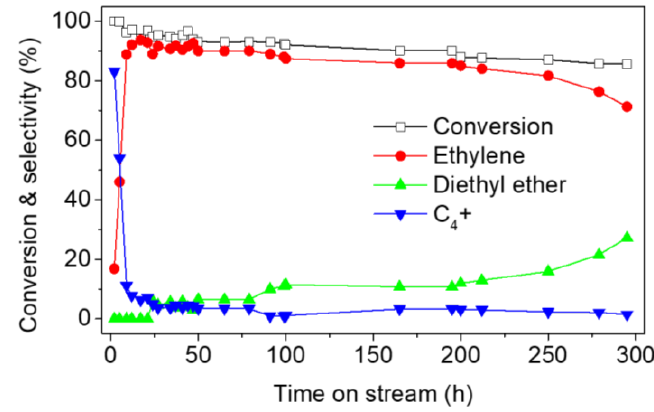
Figure 6. Et hanol conversion (□) and selectivities to ethylene (● ), diethyl ether ( ▲ ), and C 4 + compounds ( ▼ ) as a function of TOS in dehydration of bioethanol over 12 g of molded H-ZSM-5A4 catalyst at 260 °C and 2 h − 1 WHSV.